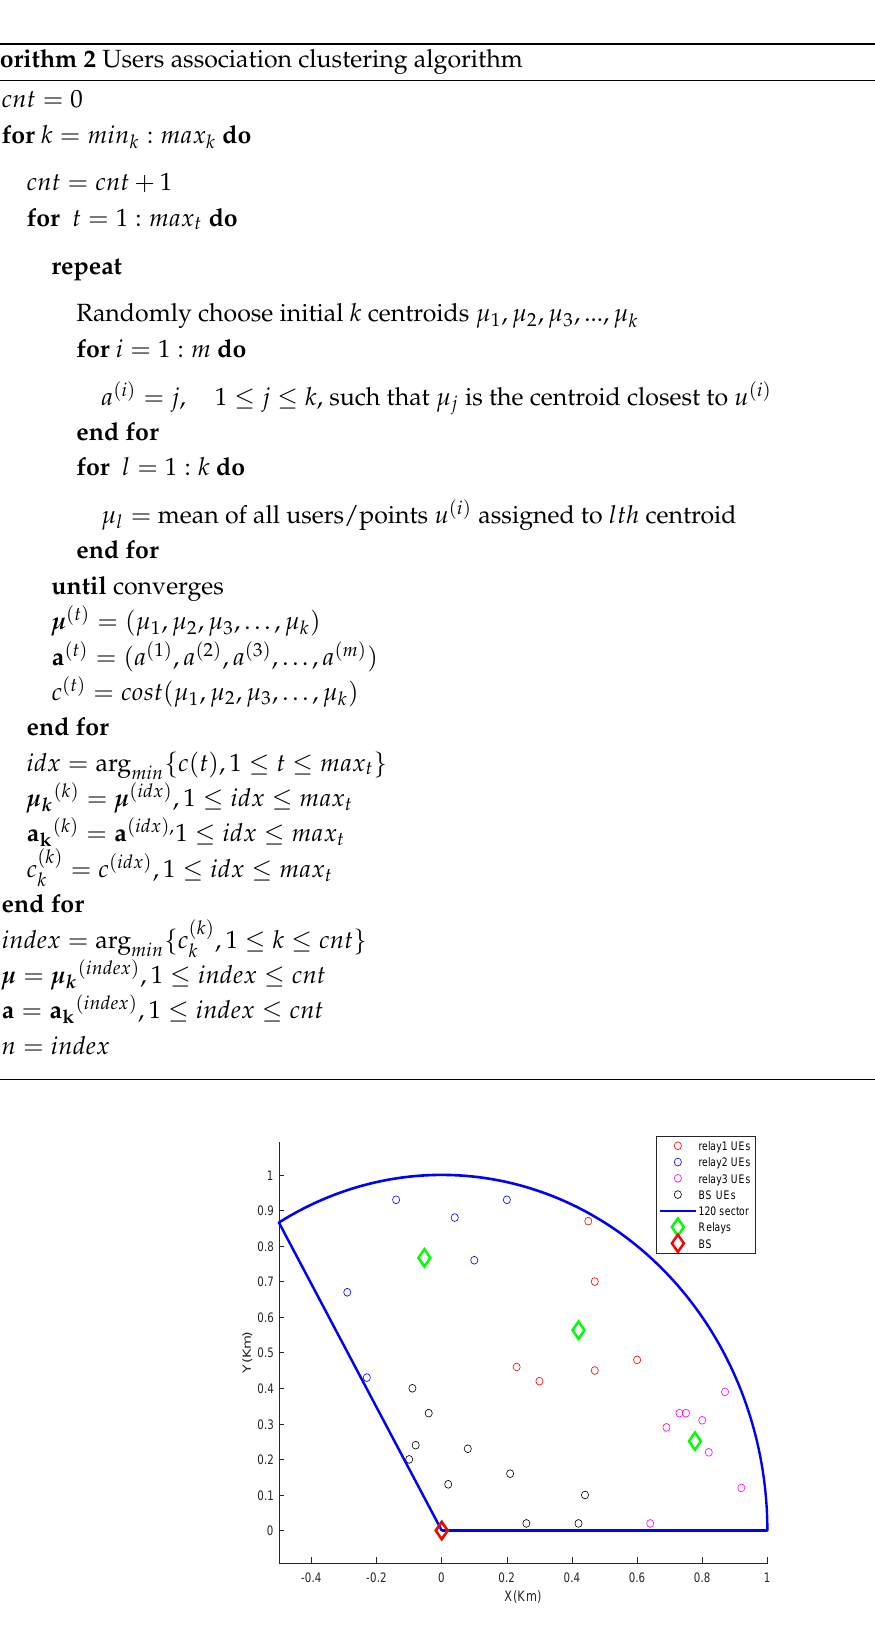
Figure 9. A snapshot of the relay deployment and users’ association algorithm output in a 120 degree